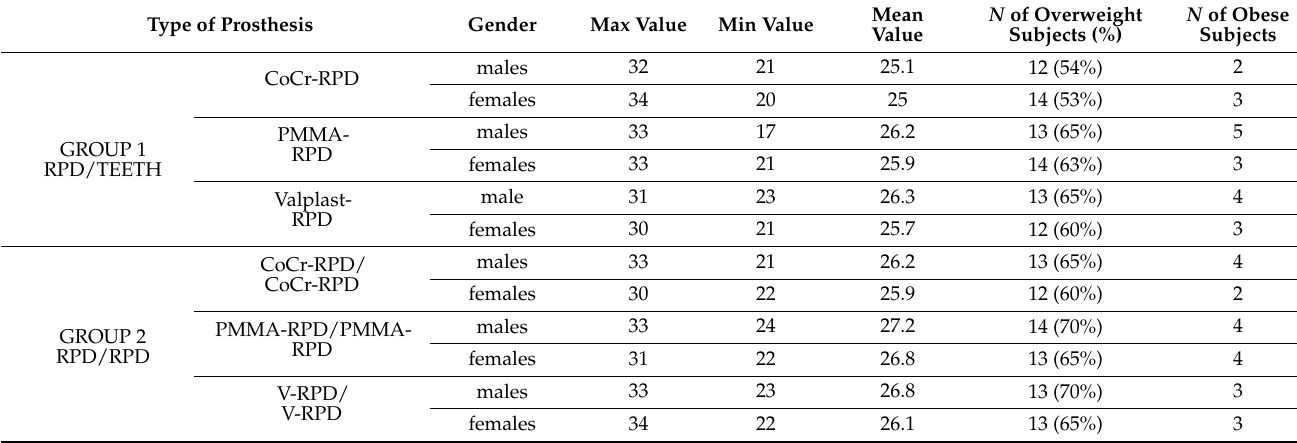
Table 2. Body Mass Index in the 6 subgroups. [MBF = Maximum Bite Force (kg); UBF = Usual bite force (40% of